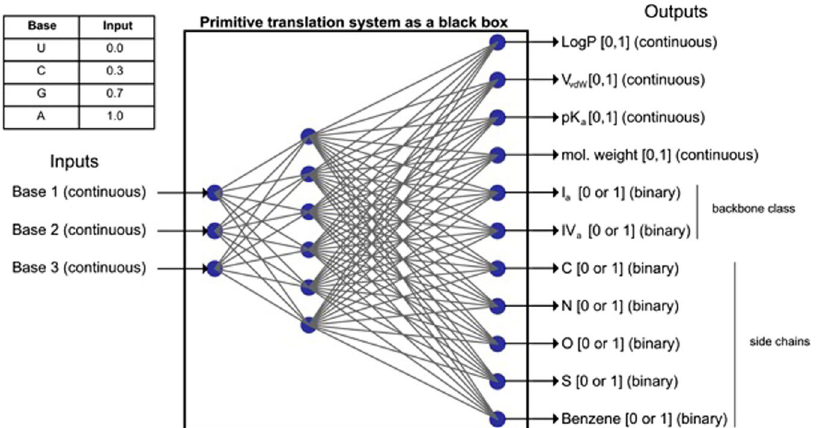
Figure 2. ‘Black box’ of a protocell’s primitive translation system. For simplicity, and following previous work on the iterated learning model, we used a fully interconnected feed-forward multi-layer perceptron network to model the translational mapping from a codon to its corresponding amino acid. There are three input nodes, one for each of a codon’s bases. The order of base positions is arbitrary and interchangeable (no third base ‘wobble’). There are six hidden nodes. Output is an 11-dimensional vector that specifies an amino acid in terms of properties by which it can be uniquely distinguished in chemical